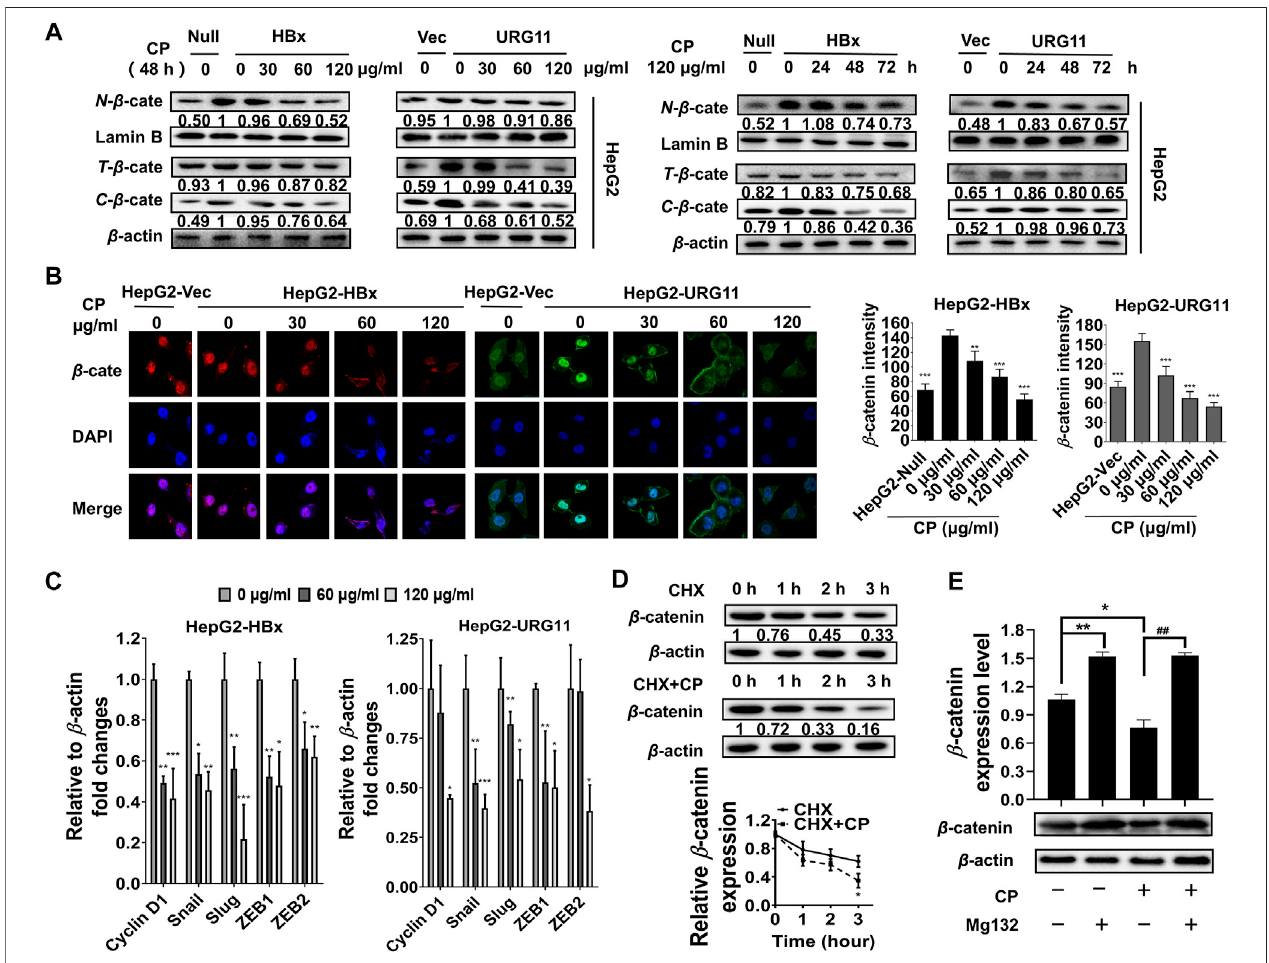
FIGURE 3 | CP suppressed metastasis of HBV-associated HCC via promoting the destabilization of β -catenin. (A) CP decreased both total and fractional expression levels of β -catenin in HepG2-HBx and HepG2-URG11 cells. (B) Immuno fl uorescence analysis presented that CP inhibited the nuclear accumulation of β -catenin. (C) QPCR array showed that the proliferation-related TF Cyclin D1 and the EMT-related TFs Snail , Slug , ZEB1 and ZEB2 were simultaneously suppressed by CP. (D) β -catenin downregulation was triggered in the CHX group while its degradation was remarkably accelerated in the CHX + CP group. (E) Meanwhile, proteasome inhibitor MG132 inhibited CP induction of β -catenin degradation. All values represented the means ± SD ( n (cid:1) 3, * p < 0.05, ** p < 0.01, *** p < 0.001, ## p < 0.01).